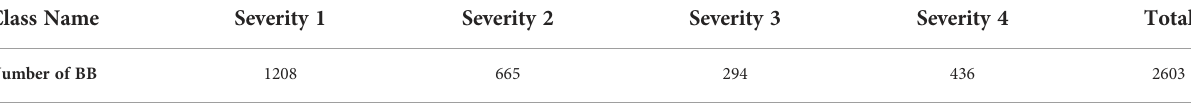
TABLE 1 Breakdown of number of bounding boxes for each of the four severity